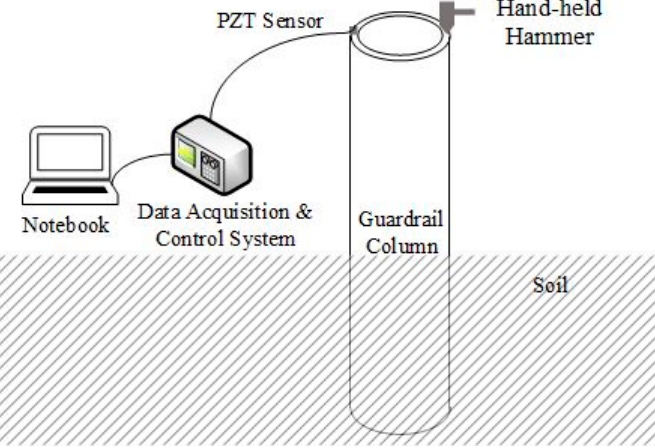
Figure 3. Schematic diagram of the experimental device.